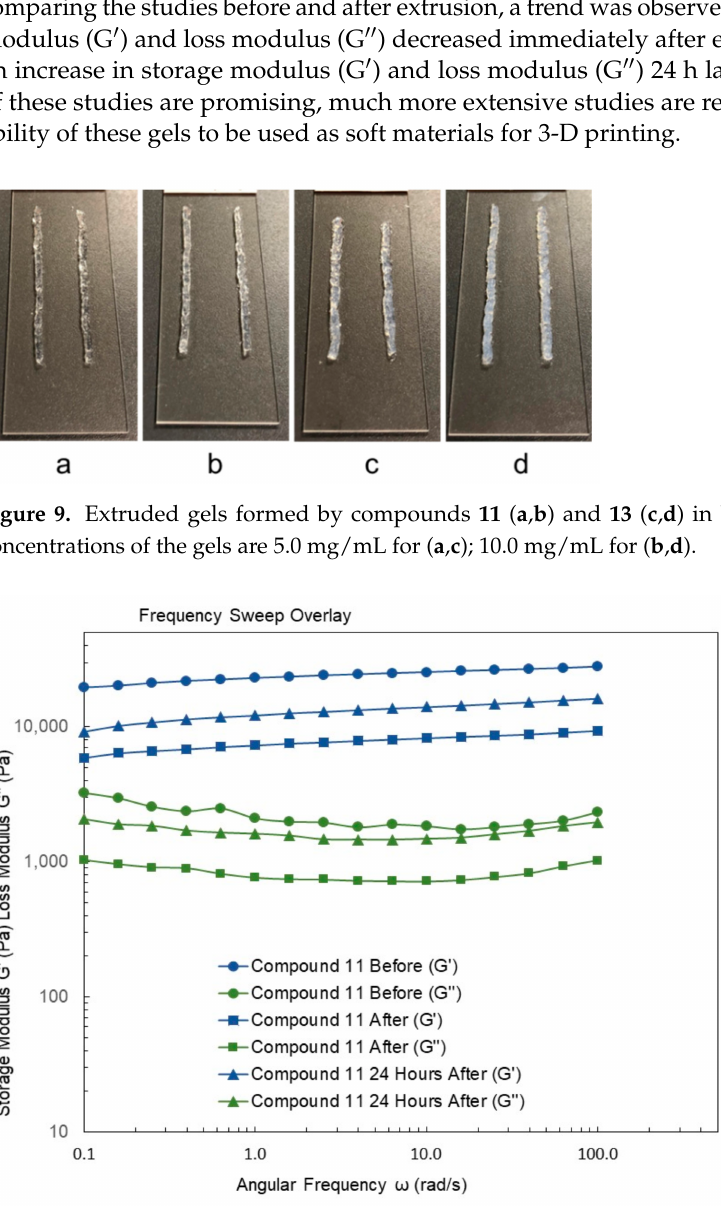
Figure 10. Rheology properties (frequency sweep, 0.5% strain) of a gel of compound 11 in DMSO/H 2 O 1:1 at 5 mg/mL before and after extrusion, and 24 h after